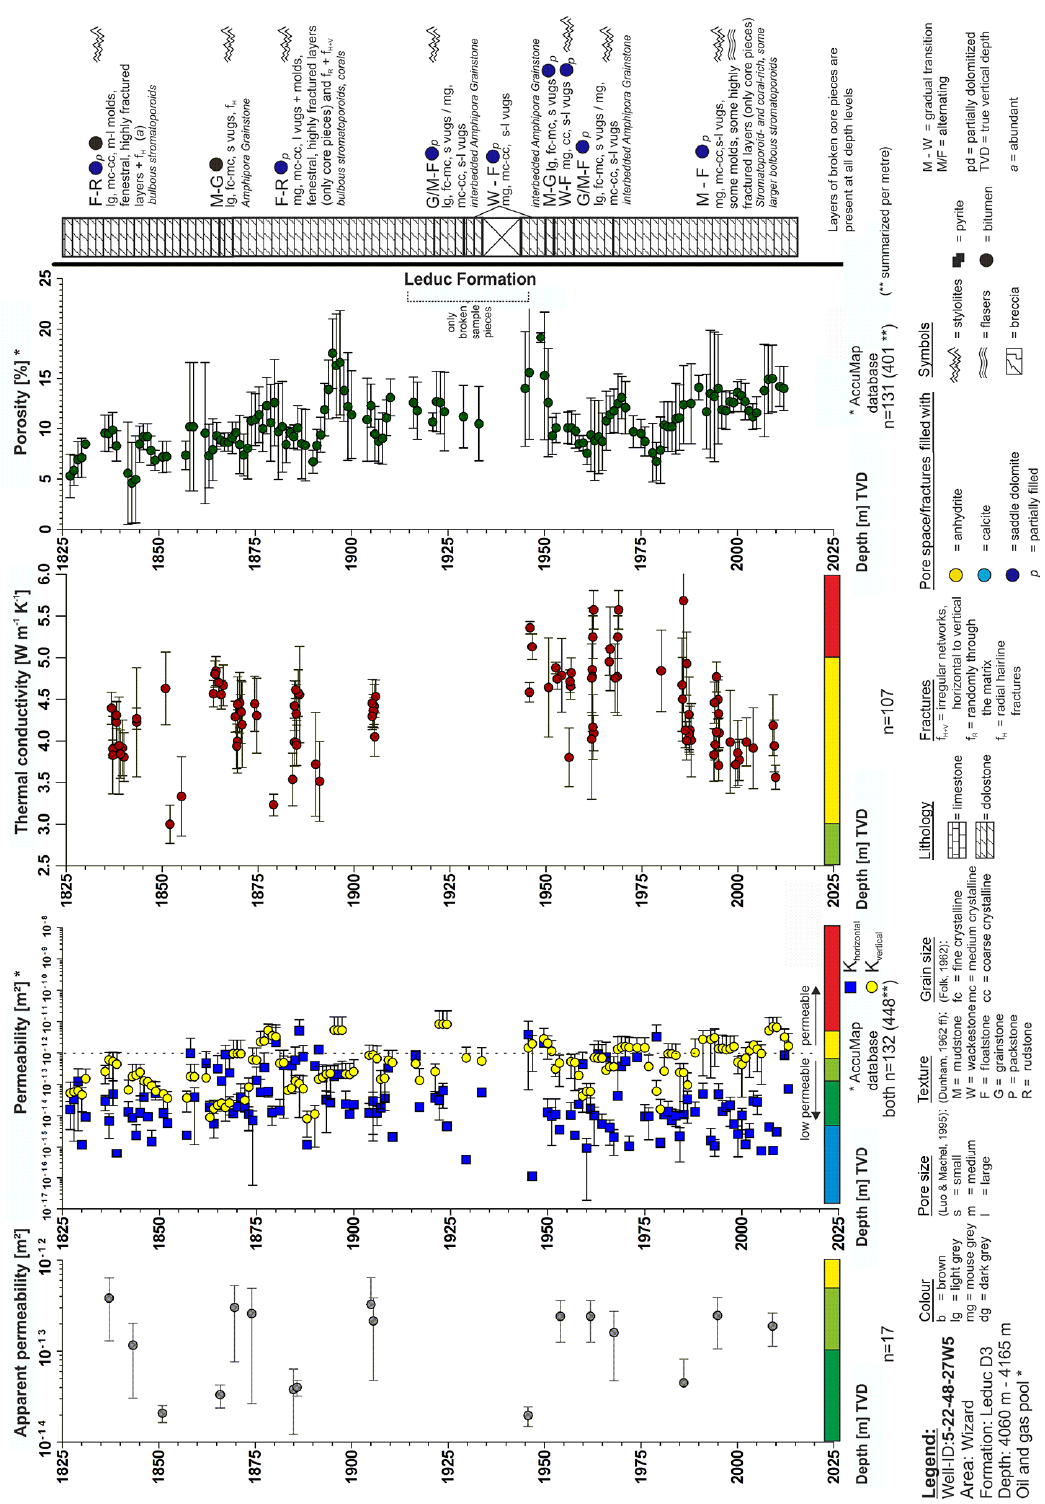
Figure 11. Rock properties of well 5-22-48-27W5 (Leduc Formation, RMRT). Apparent permeability and thermal conductivity are dis- played as arithmetic mean values with standard deviation for every analyzed core sample. Permeability and porosity were retrieved from the AccuMap database. Due to the high number of measurements and for clarity reasons, the values were summarized per metre and are also displayed as mean values with standard